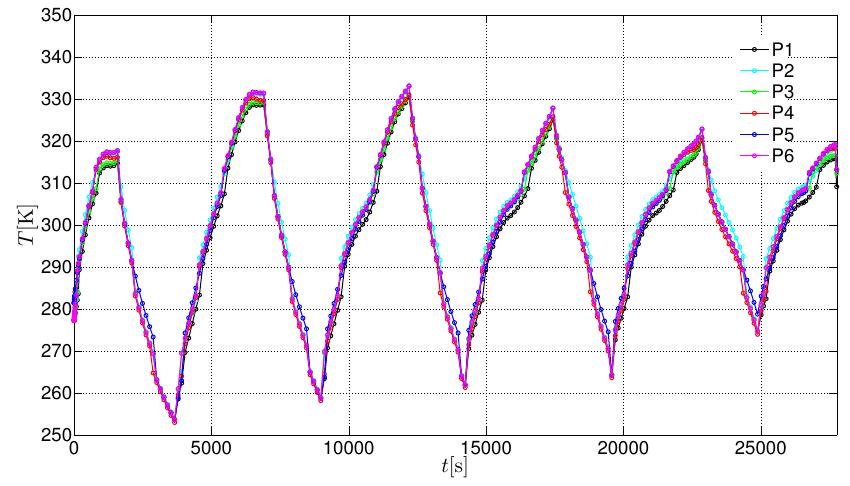
Figure 9. Average temperature in each aluminum panel as function of time ( β = 57 ◦